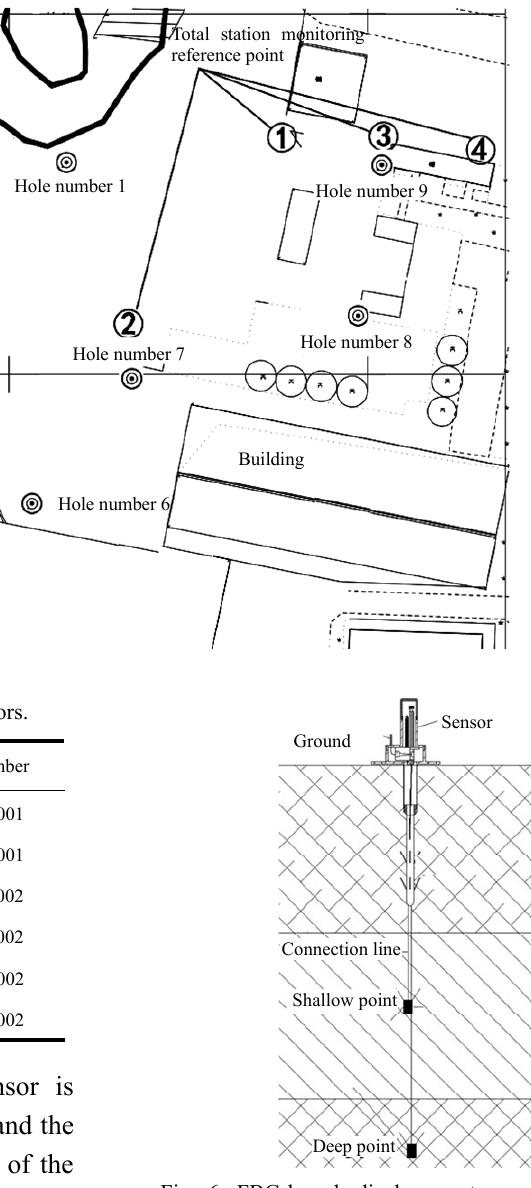
Fig. 6 FBG-based displacement monitoring installation design.